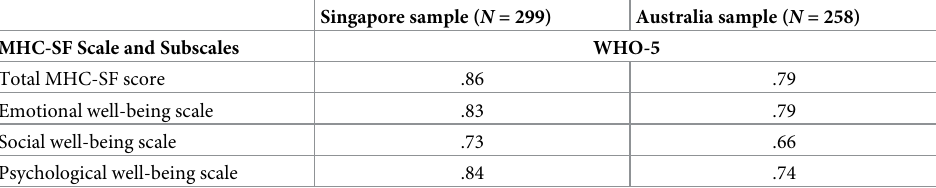
Table 8. Pearson’s correlations of MHC-SF and WHO-5.